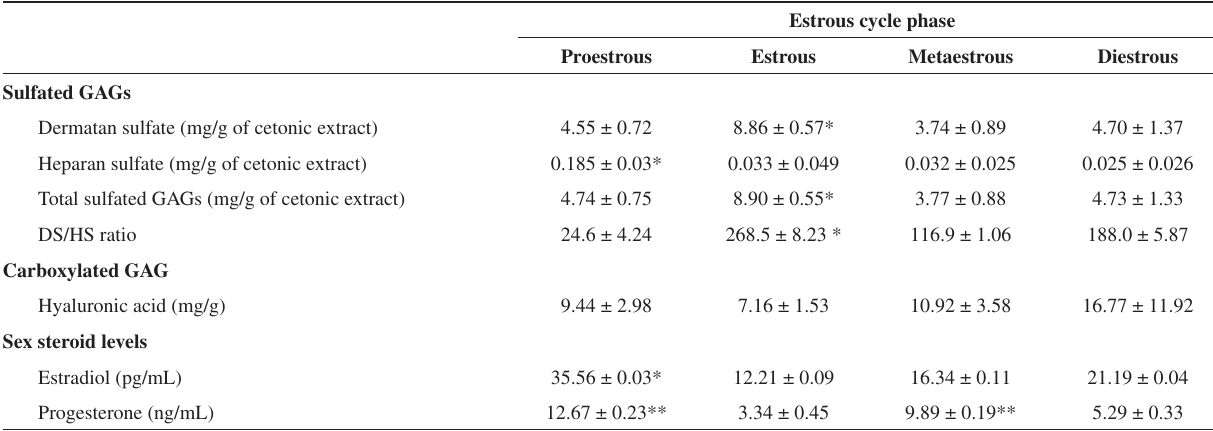
Table 1 - Concentrations of glycosaminoglycans (GAGs) extracted from uterine cervices of rats in different phases of the estrous cycle (mean ±